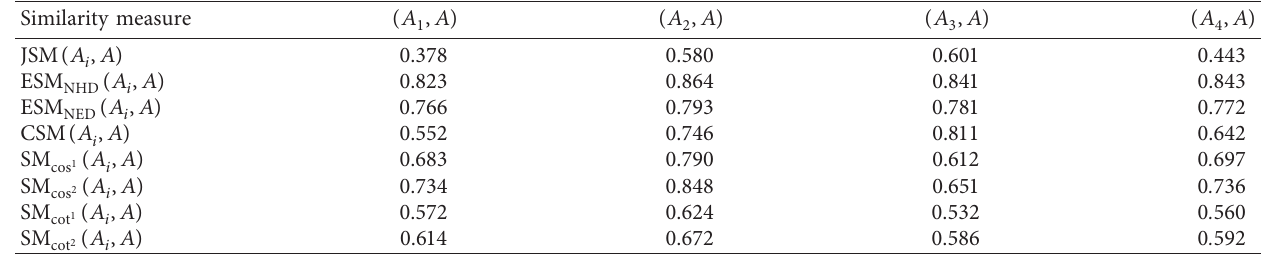
Table 2: The similarity measures between A